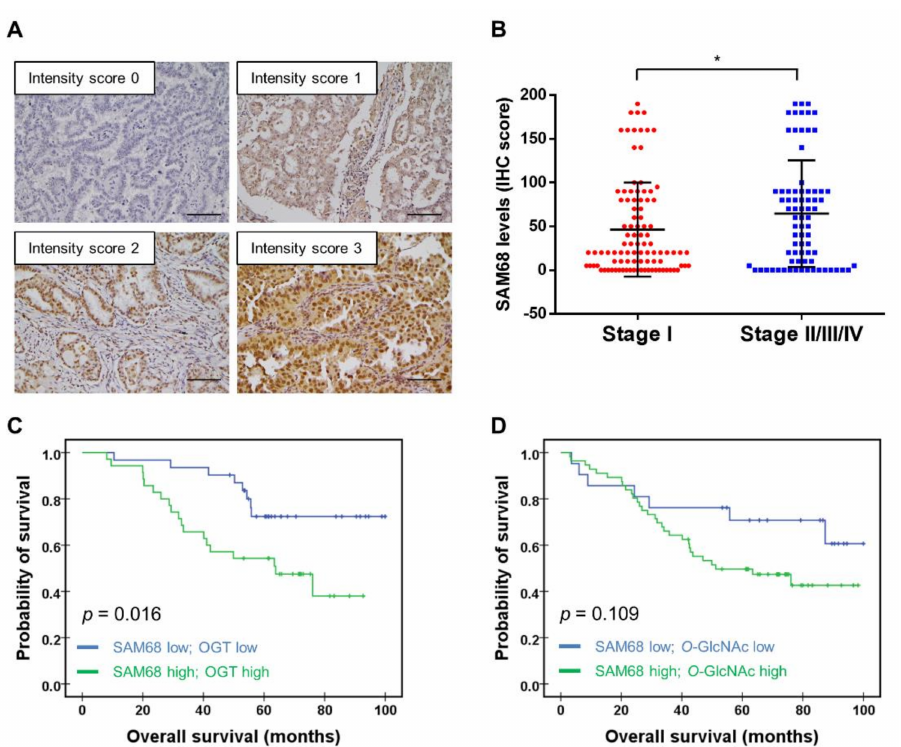
Figure 6. Association of SAM68 expression with lung cancer stage and patient outcome. ( A ) Analysis of SAM68 protein expression in clinical specimens of lung adenocarcinoma by immunohistochemistry (IHC). Shown are images representing different IHC staining intensity scores: negative (0), weak (1), moderate (2), and strong (3). Scale bar, 100 µ m. ( B ) Analysis of SAM68 expression in lung adeno- carcinoma tissues in relation to cancer stage. ( C – D ) Kaplan-Meier survival analysis of patients with lung adenocarcinoma categorized according to SAM68/OGT ( C ) or SAM68/ O -GlcNAc ( D ) levels. p -values were derived from the log-rank test; *, p <